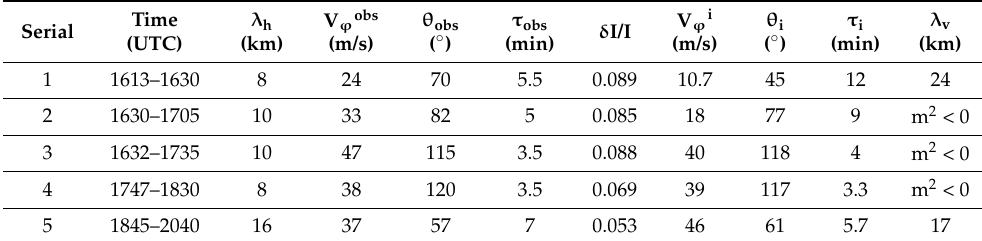
Table 2. GW parameters for 9 October 2017. First columns provide serial number, time of observation, horizontal wavelength ( λ h ), observed phase speed (V ϕ obs ), observed direction of propagation ( θ obs ), observed period ( τ obs ) and the relative intensity (dI/I). Intrinsic parameters (phase speed, direction of propagation, period) and vertical wavelength are gathered in the columns 8 to